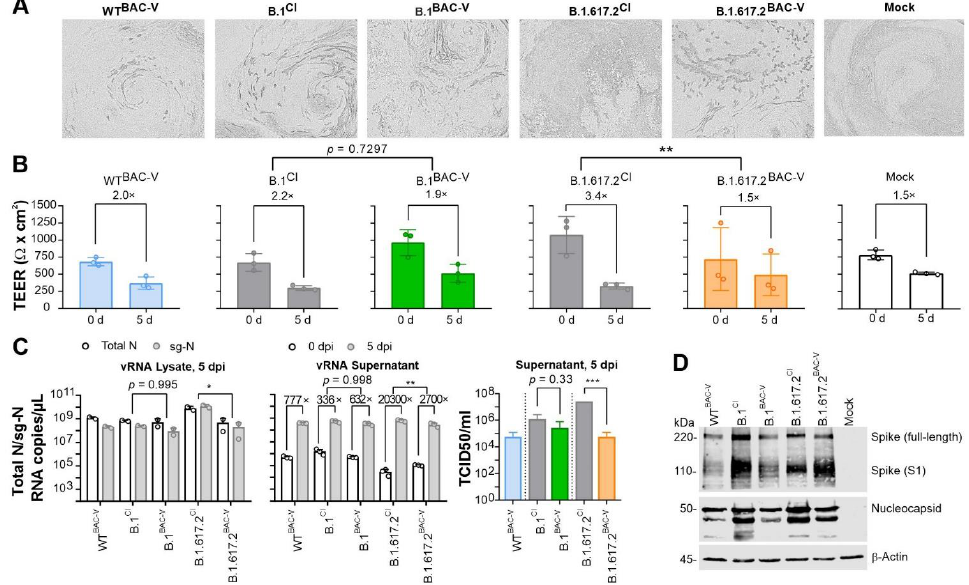
Figure 7. Infection of HBEpCs with recombinant and clinical SARS-CoV-2. ( A ). Brightfield microscopy of infected HBEpCs 5 dpi. ( B ). Epithelial barrier integrities upon infection with WT BAC-V (blue), B.1 CI (grey), B.1 BAC-V (green), B.1.617.2 CI (grey), B.1.617.2 BAC-V (orange) and in uninfected control (colorless) 0 hpi and 5 hpi. Comparison of BAC-V and CI was performed using One-Way ANOVA. Error bars represent mean and SD of three biological replicates. ** p < 0.01. ( C ). RNA copies/µL of intracellular vRNA, in terms of total N (white) and sg-N (grey) after 5 dpi (left), and extracellular total N vRNA (middle). Changes of RNA levels from 0 dpi (white) to 5 dpi (grey) are indicated by x-fold for supernatants. RNA levels were calculated using N standard RNA. Comparison of BAC-V and CI RNA levels for intracellular and for changes in extracellular RNA levels was performed using One-Way ANOVA. Error bars represent mean and SD of intra- and extracellular RNA comprising three and two biological replicates, respectively. * p < 0.05, ** p < 0.005. Virus titers in supernatant 5 dpi are indicated for WT BAC-V (blue), B.1 CI (grey), B.1 BAC-V (green), B.1.617.2 CI (grey) and B.1.617.2 BAC-V (orange) (right). Error bars represent mean and SD of three biological replicates. Statistical comparison of BAC-V and CI was performed using unpaired t -test. *** p < 0.001. ( D ). Western blot analysis for spike and nucleocapsid expression in HBEpC infected with indicated viruses. β -actin detection served as a loading control.